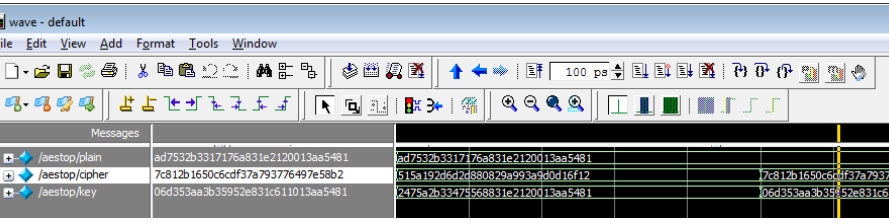
Figure 6. Overall simulation waveform of AES-FJMKE architecture. Table 7. Results of cipher text for AES-FJMKE architecture.